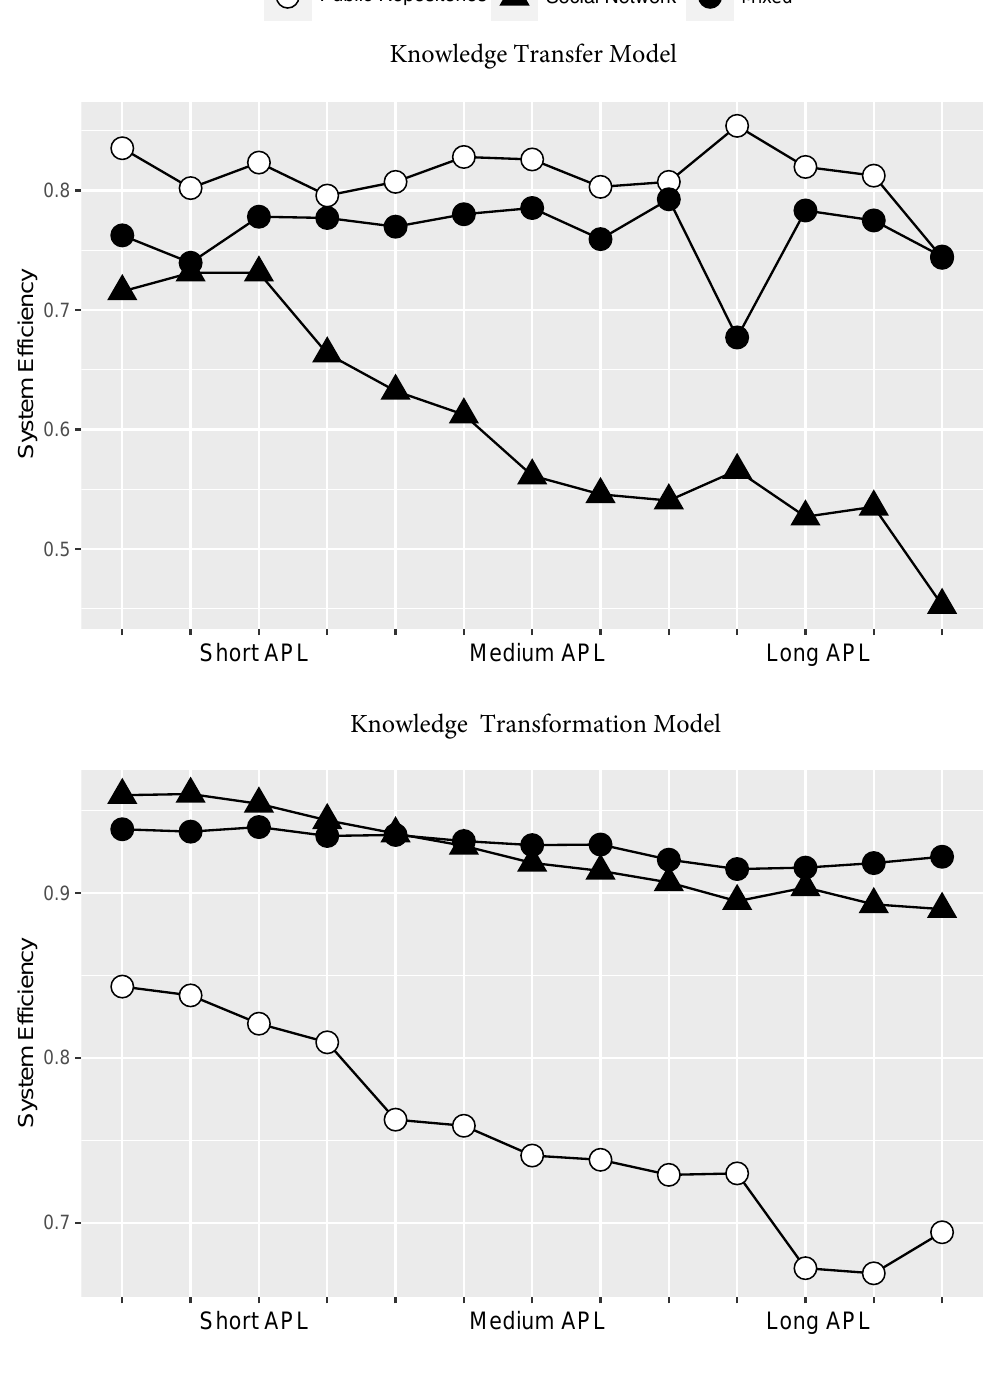
Figure 2: Effects of network APLs for information systems on efficiency (upper plot: the knowledge transfer model; lower plot: the knowledge transformation